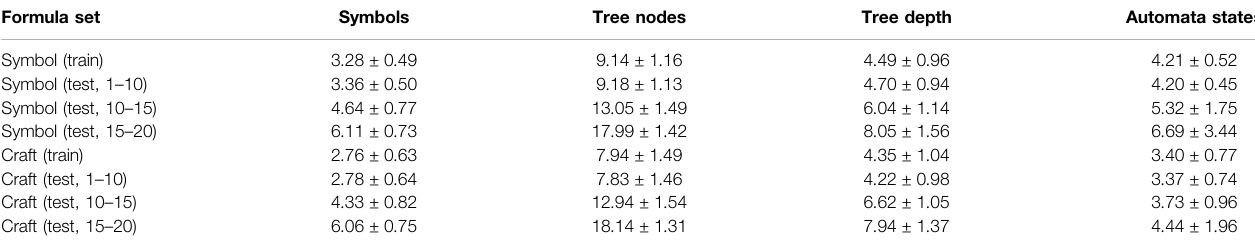
TABLE 1 | Statistics of the generated formulas used in the Symbol domain and the Craft domain. Each test set is summarized using the mean and standard deviation of the number ofsymbolsintheformula, totaltreenodesintheparse oftheformula, depthoftheparse ofthe formula, and thestates inthe Buchiautomata forthose formulas. Formula set Symbols Tree